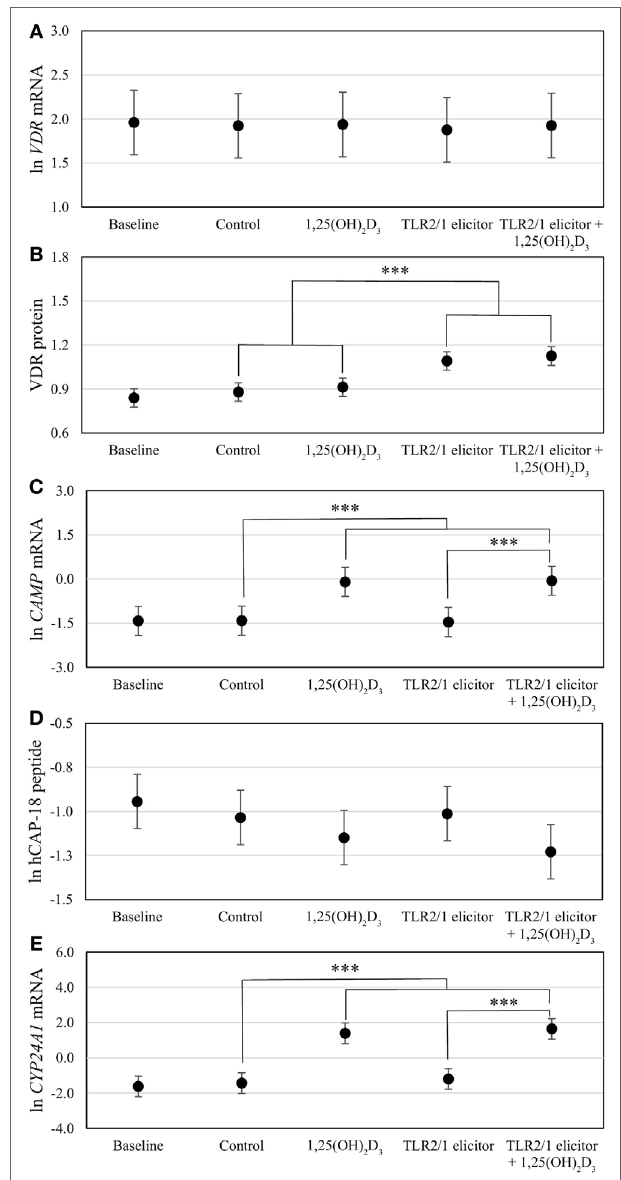
FigUre 3 | Differential vitamin D receptor (VDR)-mediated innate immune response to toll-like receptor (TLR) 2/1 elicitation, with or without in vitro 1,25(OH) 2 D 3 supplementation. The error bar plots show mean levels for VDR mRNA (a) , VDR protein (B) , CAMP mRNA (c) , hCAP-18 peptide (D) , and CYP24A1 mRNA (e) , for healthy South Africans ( n = 100). Gene expression (mRNA) was quantified by RT-qPCR and protein or peptide level by flow cytometry. Significant treatment effects are shown (*** P < 0.001). All significant differences were maintained after Bonferroni correction. Error bars show the least significant difference at P <